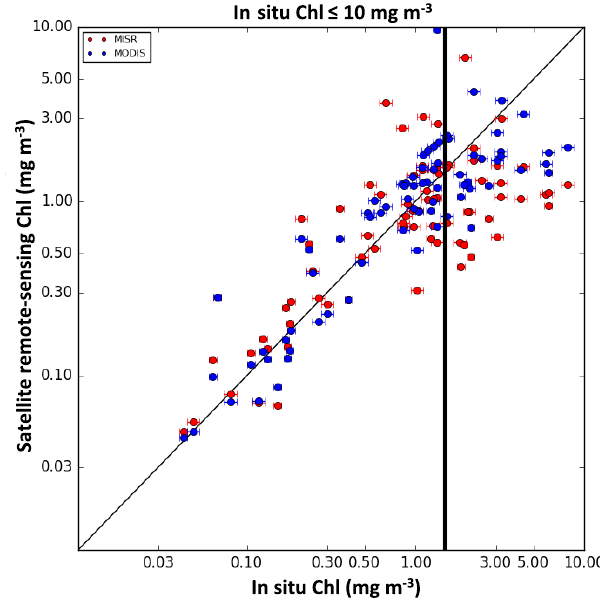
Figure 3. MISR (red points) and MODIS (blue) Chl plotted against SeaBASS validation data for Chl insitu ≤ 10. Results are presented if both MODIS and MISR have at least one valid retrieval in a 5 × 5 pixel box surrounding the central SeaBASS location. The ver- tical black line represents Chl insitu = 1 . 5. We expect better-quality MISR Chl retrievals to the left of this line.